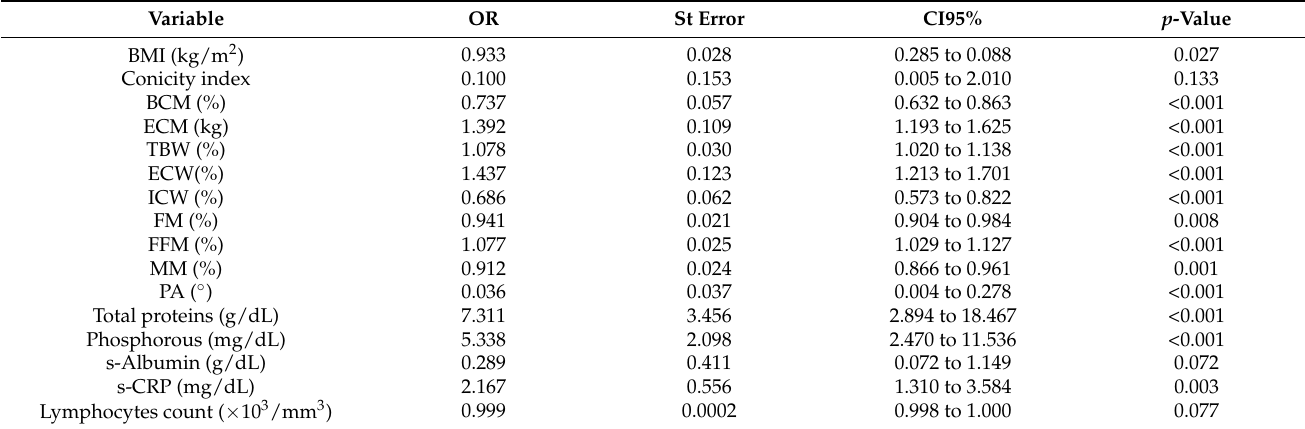
Table 3. Univariate conditional regression analysis in cases and